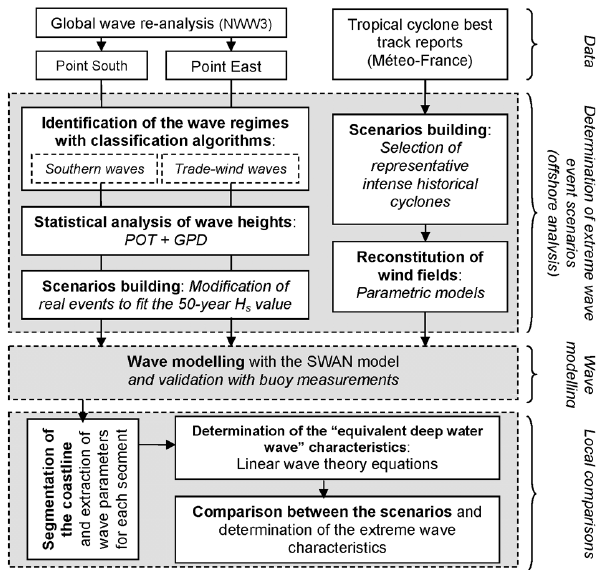
Fig. 2. Diagram of the overall